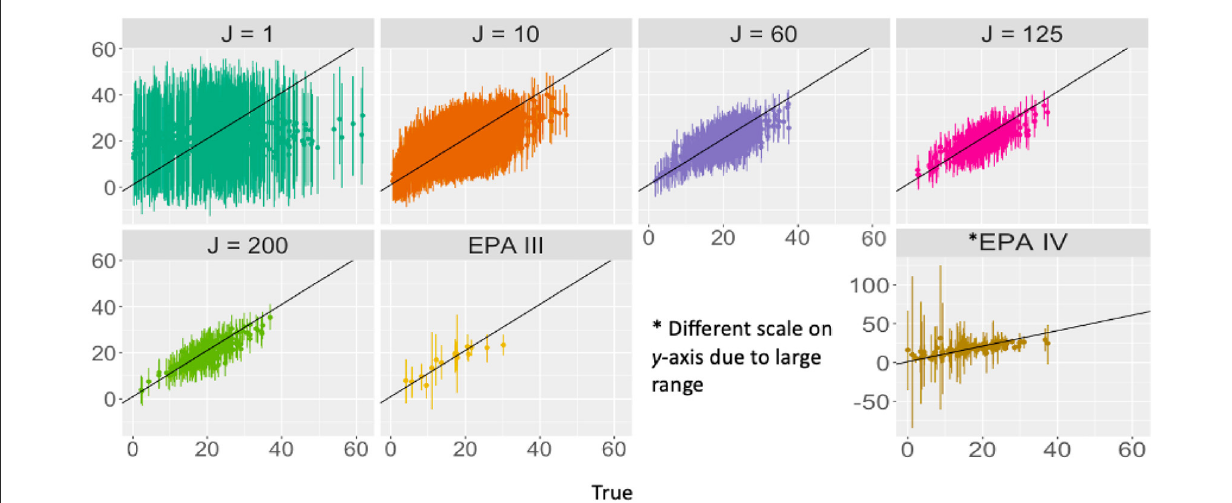
FIGURE6 True and predicted total basal area with 95% prediction intervals at different levels of aggregation. Note that with the exception of EPA IV, the axes are the same across aggregations. Predicted TBA better approximates the truth for aggregated data (black y = x line provided for comparison), and prediction error decreases with